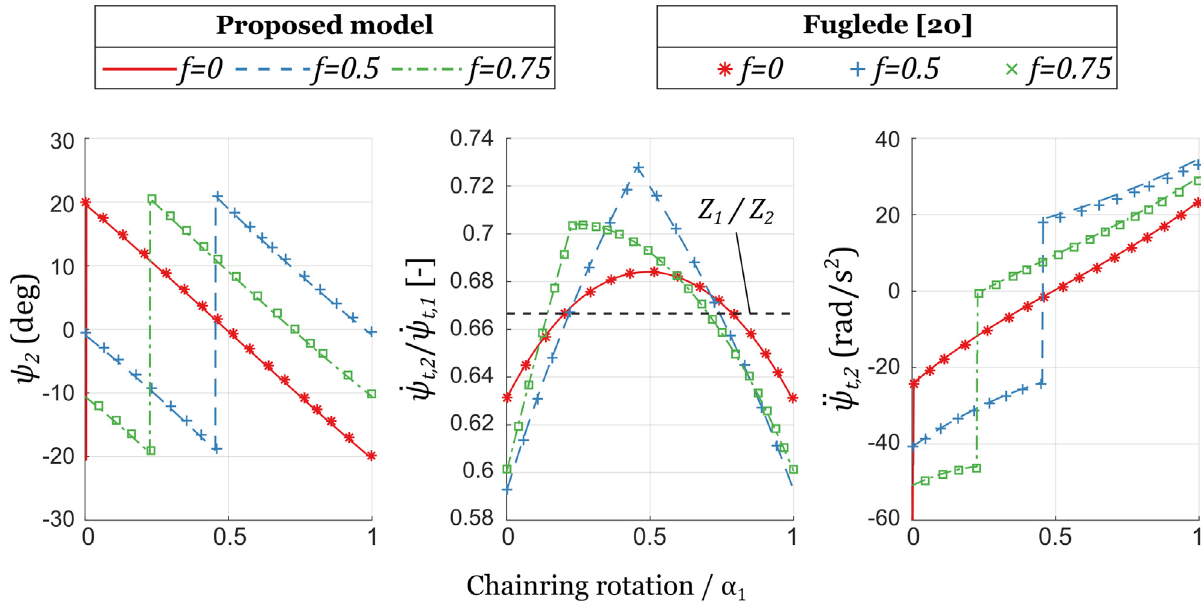
Fig. 13. Chain drive kinematics, comparison with Fuglede et al. [21].